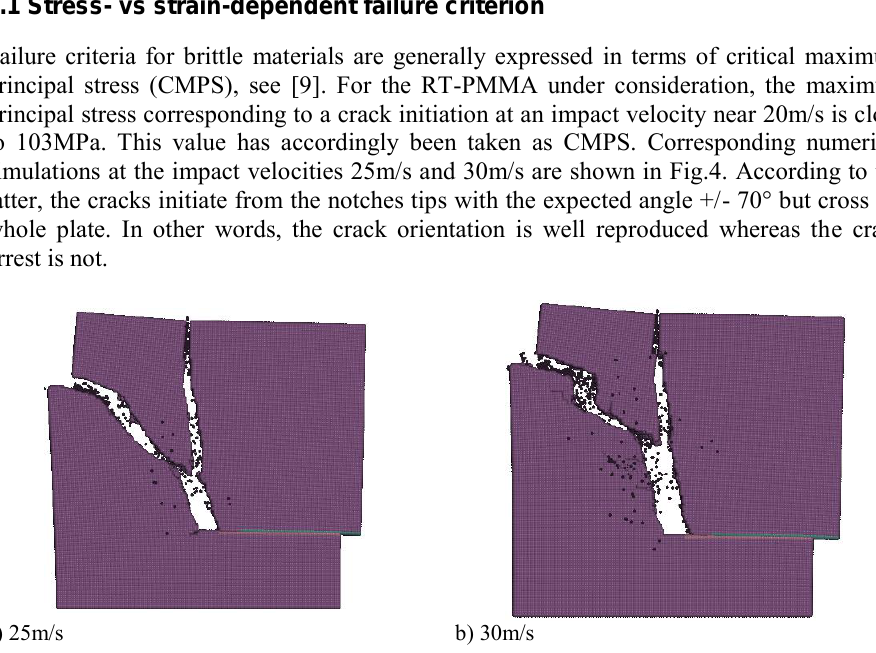
Fig. 4. Numerical simulations. Maximum principal tress-dependent failure criterion. CMPS=103MPa. To be compared with Fig.2.